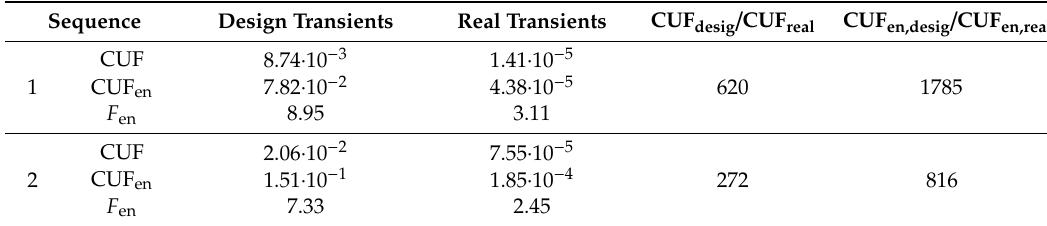
Figure 7. Temperature and stress evolution in both the cold leg and the charging line during the second sequence of transients. ( a ) Design temperature; ( b ) design stresses; ( c ) in-plant temperature; ( d ) in-plant stresses. Dates on the horizontal axes do not necessarily correspond to actual dates. Table 3. Environmental fatigue assessment (EFA) of the inner radius location for the two sequences of transients being considered.